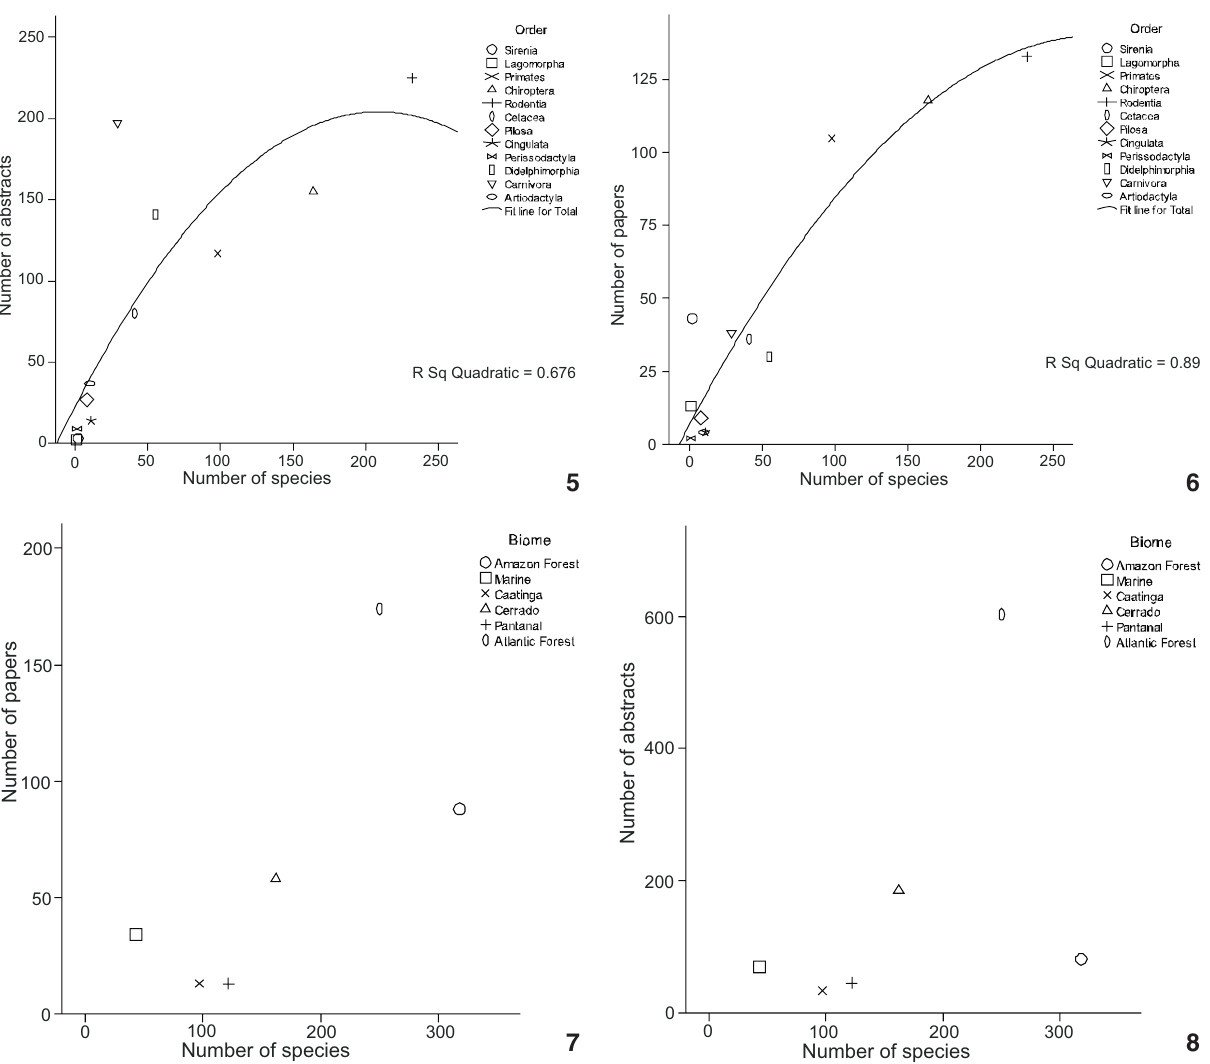
Figures 5-8. Relationship between the number of publications and the number of species for each mammalian order (5: abstracts,